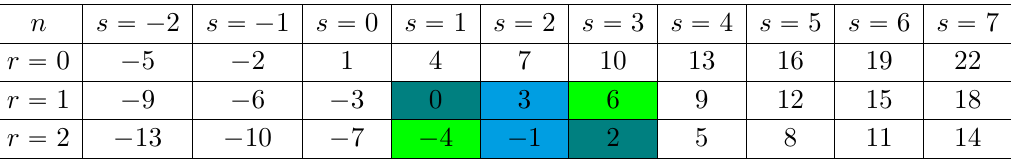
Table 3 . Values of the momentum n of some operators in the p 4 , 3 q compact linear